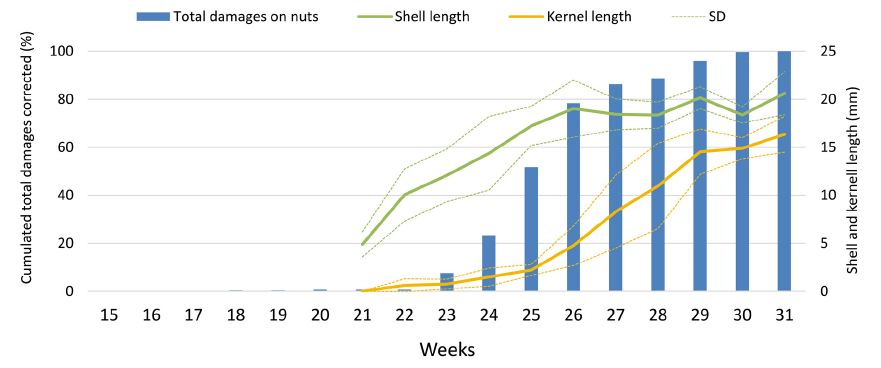
Figure 3. Cumulative rate of total hazelnut damage (belted nuts, blank nuts, and wormy nuts) by weevils, corrected from natural hazelnut defects in the control net sleeves, in relation to hazelnut